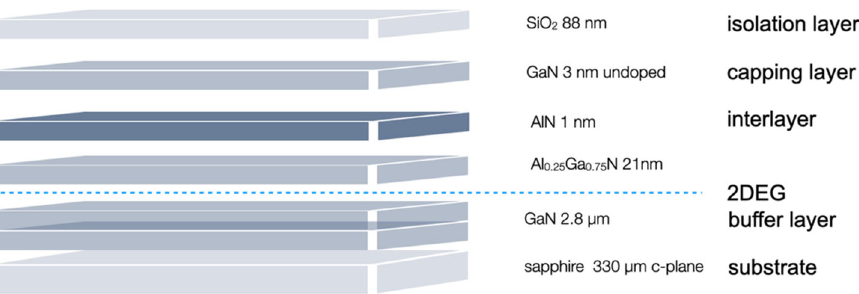
Figure 1. Schematic drawing of the GaN HEMT heterostructure. Dotted line shows the 2DEG